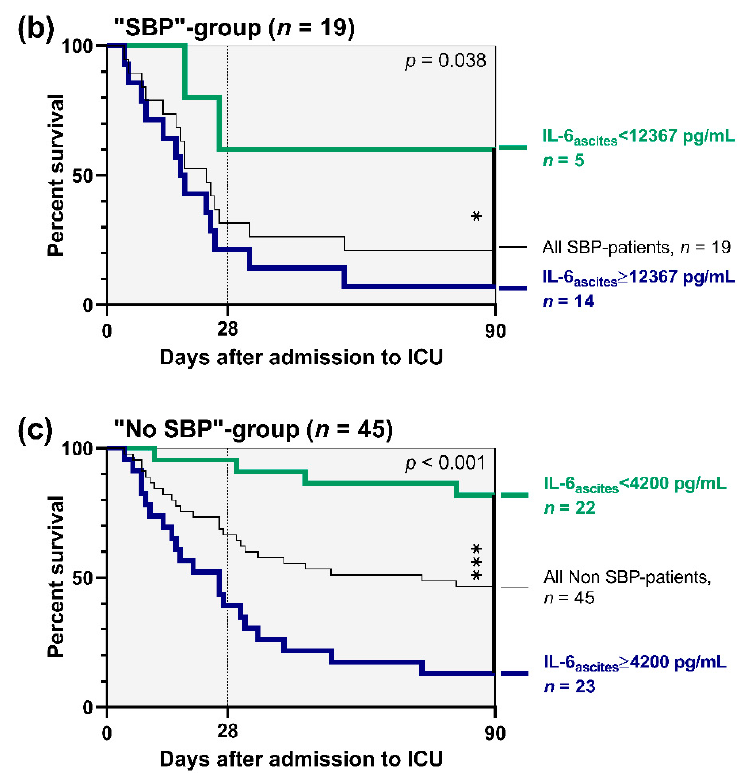
Figure 2. Survival analyses depending on baseline ascitic interleukin 6 (IL-6 ascites ): ( a ) total population of 64 patients (admission levels of IL-6 ascites < 4200 pg / mL vs. ≥ 4200 pg / mL); ( b ) “ SBP ” subgroup of 19 patients (admission levels of IL-6 ascites < 12,367 pg / mL vs. ≥ 12,367 pg / mL); ( c ) “ no SBP ” subgroup of 45 patients (admission levels of IL-6 ascites < 4200 pg / mL vs. ≥ 4200 pg / mL). ICU, intensive care unit. * = p < 0.05; *** = p < 0.001.